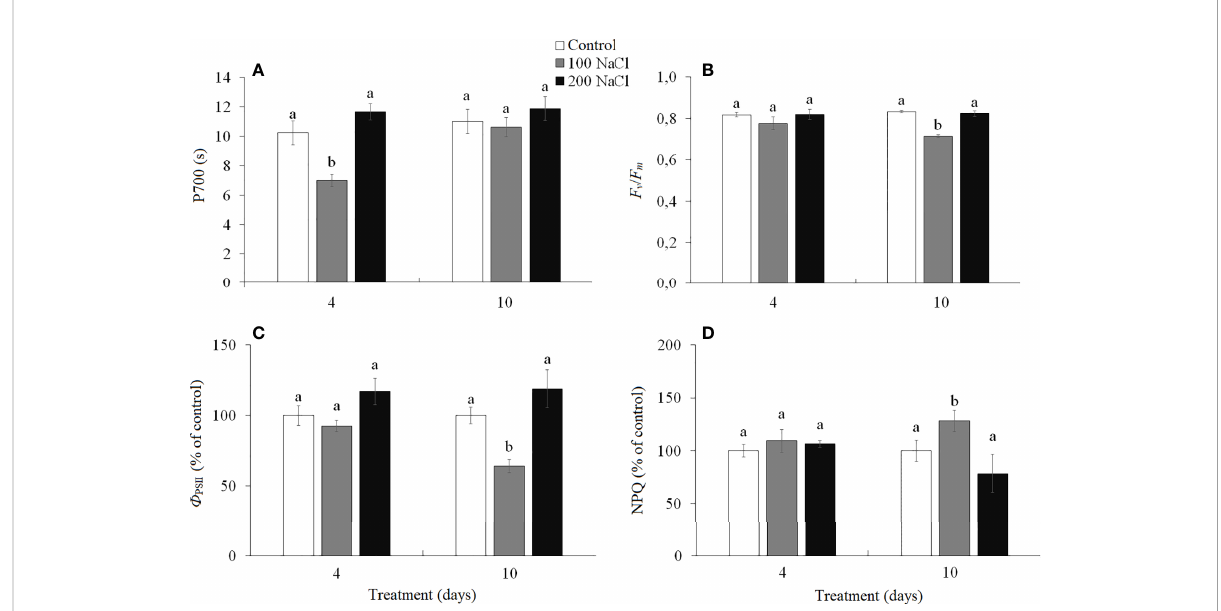
FIGURE 3 Effect of 4- and 10-days treatments with low (100 mM NaCl) and moderate (200 mM NaCl) salinity on photosynthetic parameters in Kochia prostrata shoots. (A) P700 — time required to reach the maximum P700 oxidation level under far-red light (PSI); (B) F v / F m — maximum quantum yield of PSII; (C) Ф PSII — effective quantum yield of PSII at given light intensity; (D) NPQ — non-photochemical quenching of chlorophyll a fl uorescence. Values are means ± standard errors of one experiment with three biological replicates. The different letters show statistically different means at P ≤ 0.05 (Tukey